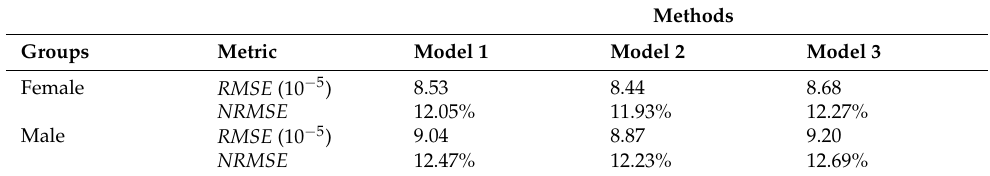
Table 2. Predictive performance of three linear regression models with different predictor